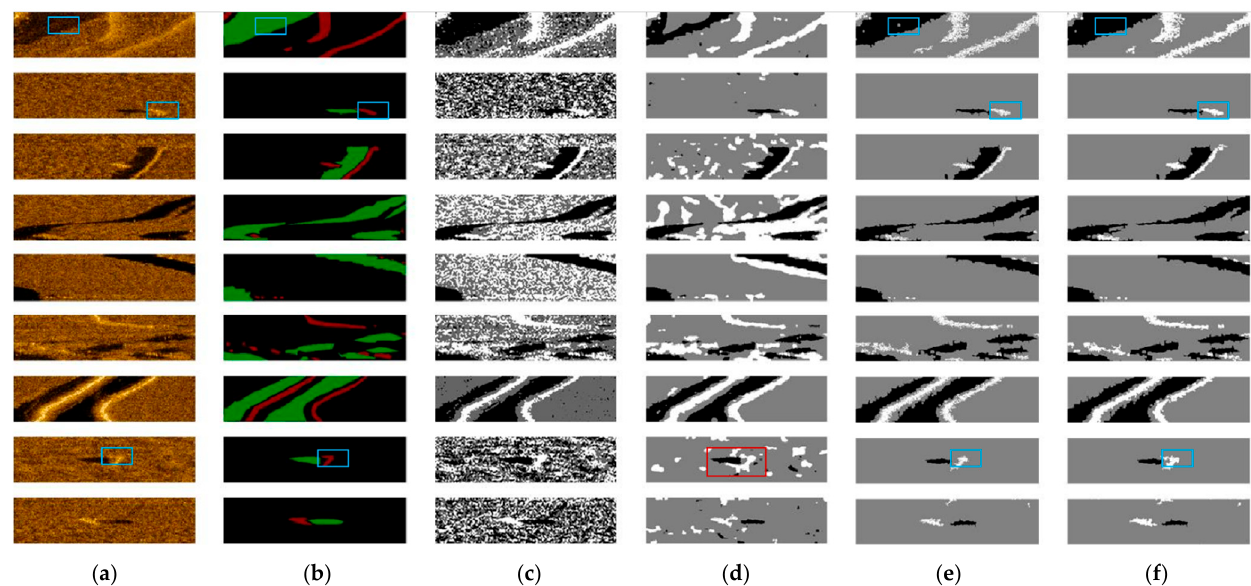
Figure 5. Segmentation results of the four methods: ( a ) The real sonar images. ( b ) The corresponding manually labeled ground truth segmented images. The green areas represent the shadow areas, and the red areas represent the highlighted areas. ( c ) The segmentation results of fuzzy C-means. ( d ) The segmentation results of the active contour. ( e ) The segmentation results of RGLT I. ( f ) The segmentation results of RGLT II.